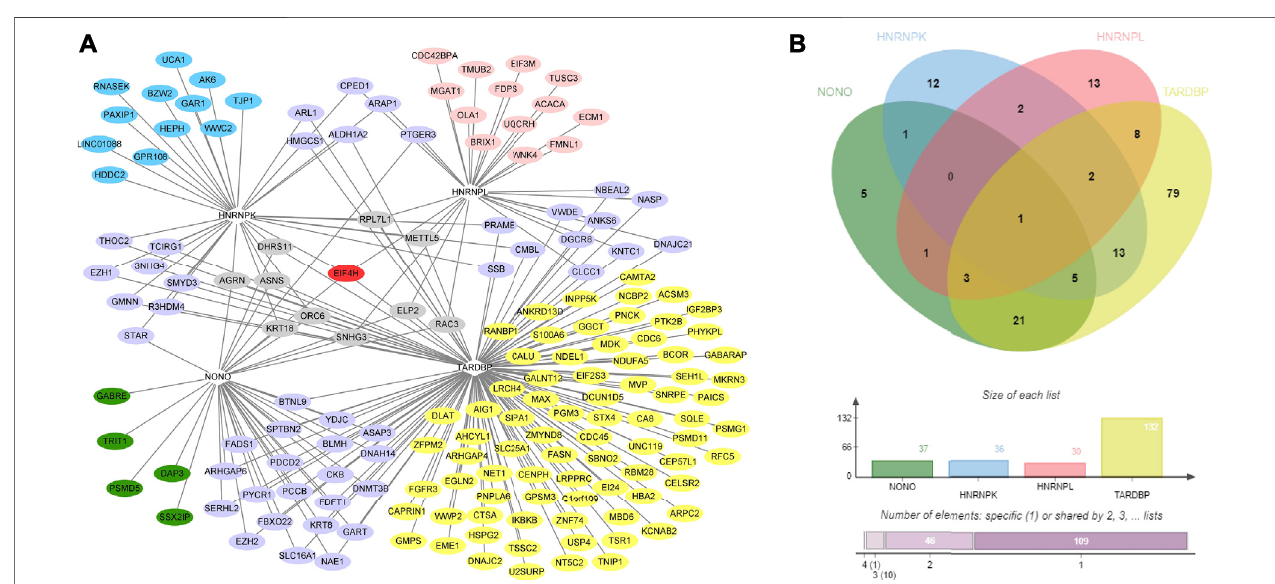
FIGURE5| Co-regulatorygenenetworkdiagramofthe4DNA-andRNA-bindingproteinssplicingfactors(DRBP-SFs)andanalysisoftheirVennanalysis. (A) Two- layer co-regulated gene network diagram of the four proteins; red indicates a gene co-regulated by all four proteins, gray indicates the genes co-regulated by three proteins, purple indicates the genes co-regulated by two proteins, blue indicates the genes regulated by heterogeneous nuclear ribonucleoprotein K, pink indicates the genes regulated by heterogeneous nuclear ribonucleoprotein L, green indicates the genes regulated by non-POU domain – containing octamer – binding protein, and yellow indicates the genes regulated by TAR DNA-binding protein 43. (B) Venn analysis diagram of the co-regulation of the four proteins.